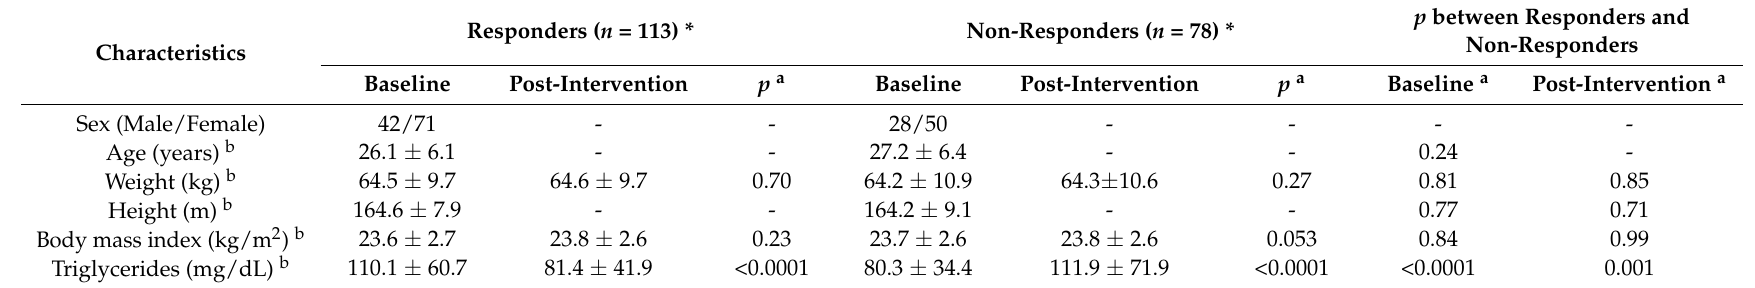
Table 1. Characteristics of Mexicans at baseline and post-intervention ( n = 191